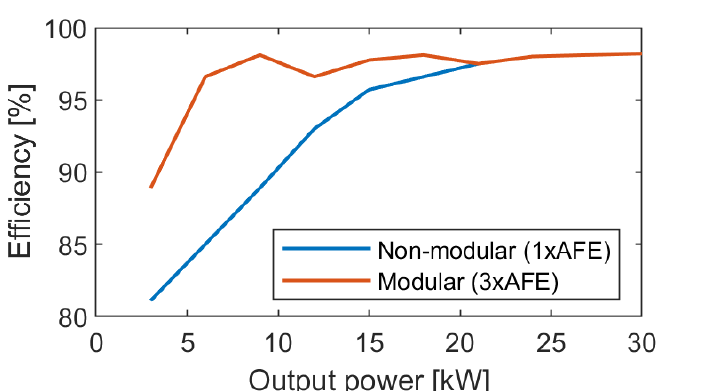
Figure 37. Simulated efficiency of modular vs. non-modular two-level AFE